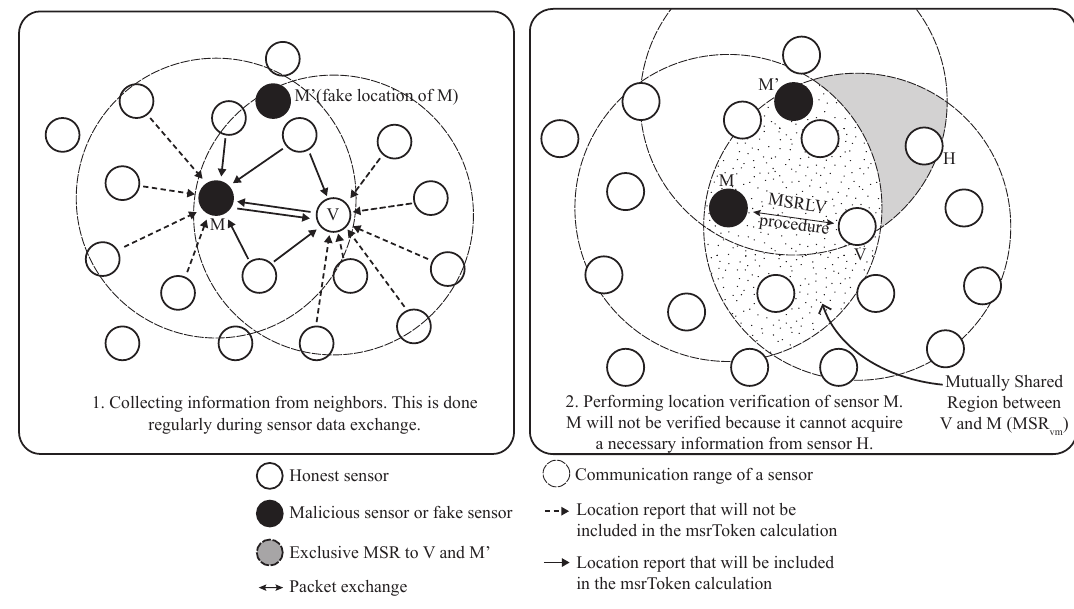
Figure 5. An example of detecting a malicious sensor with